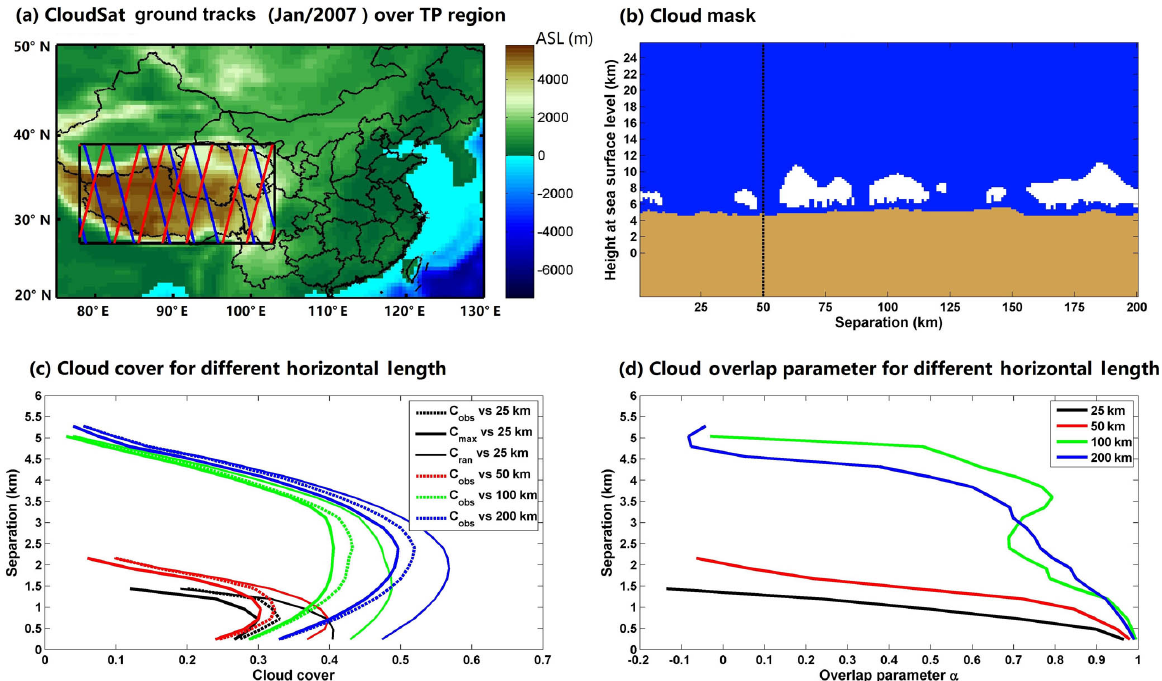
Figure 1. (a) CloudSat overpass tracks (blue line: daytime; red line: nighttime) over the Tibetan Plateau (27–39 ◦ N; 78–103 ◦ E); (b) A sample of the CloudSat 2B-GEOPROF-LIDAR cloud mask product along the ground track of 200km (white color: cloud fraction > 99%; light blue: 0 < cloud fraction < 99%; deep blue: clear sky; orange color: surface). (c) The observed and calculated segment-average cloud cover profiles based on maximum and random assumptions for different spatial scales and given cloud mask sample in (b) . (d) The corresponding cloud overlap parameters of contiguous cloud layers for 25, 50, 100, and 200km spatial scales, respectively. Note that the observations below 1km over the TP surface have been